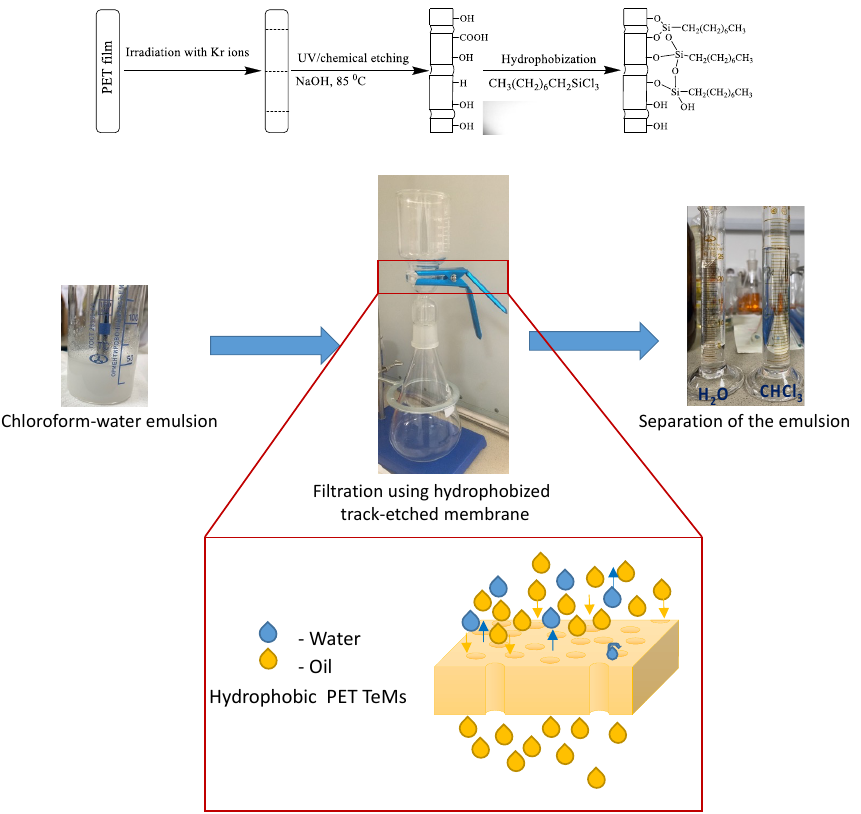
Figure 1. Scheme of PET track-etched membrane modification.